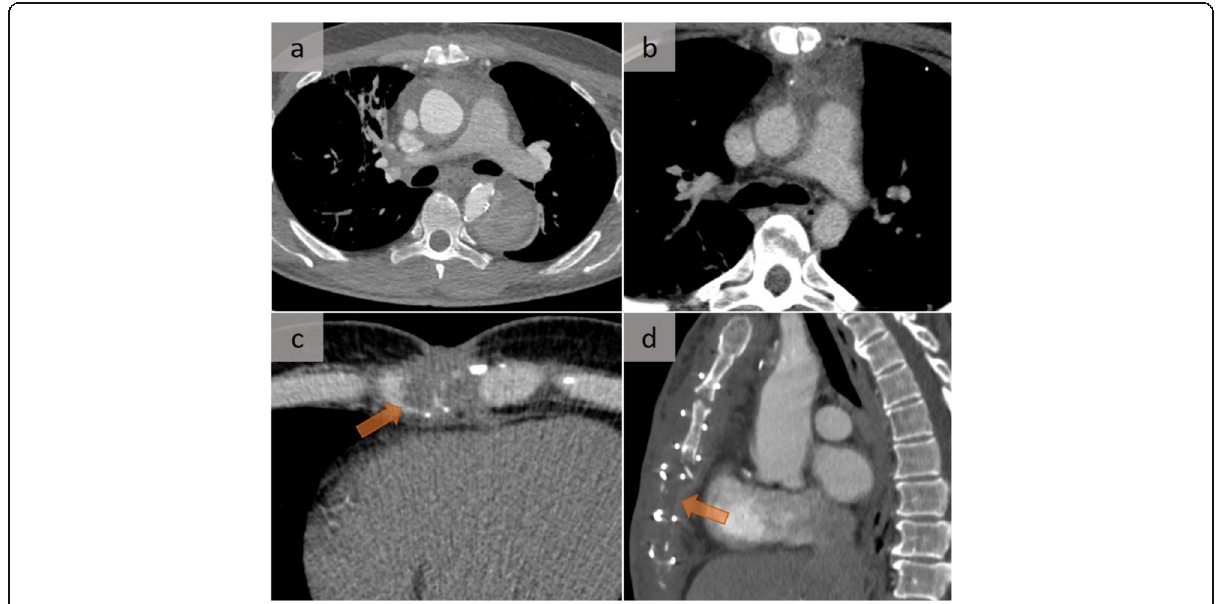
Fig. 6 Post-operative changes versus mediastinitis. Similarities of CT aspects in two different conditions: normal post-operative appearance of the mediastinum during the first 2 – 3 weeks after Bentall surgery ( a ) and mediastinitis ( b ), both presenting as an increased attenuation of fat. In addition, the careful analysis of bone and cartilage, which is required in all cases of acute mediastinitis using bone-windowing, is well demonstrated in these two different cases with cartilage abscess ( c ) and sternal osteitis ( d ), respectively